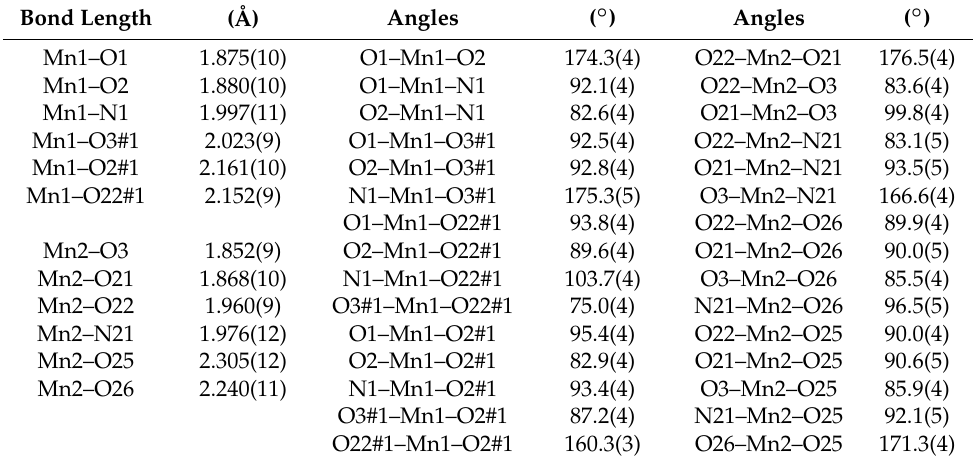
Figure 1. ( a ) Crystal structure of 1 ·H 2 O; ( b ) basic nuclei of the octahedral molecules showing the different d atomic orbitals that make the communications among manganese ions bridged them by heteroatoms O and N. Table 2. Bond length [Å] and angles [ ◦ ] of 1